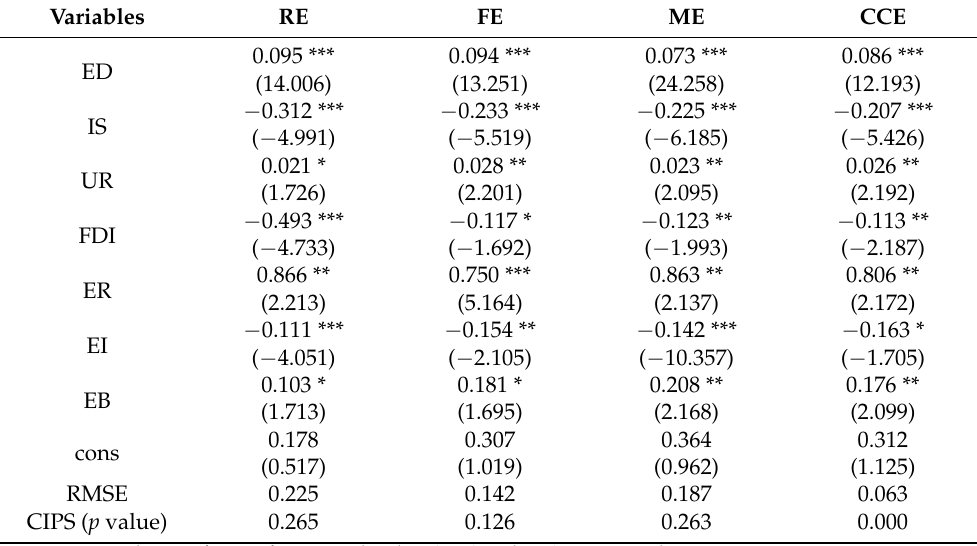
Table 6. Estimation results of factors influencing the GTFP in the